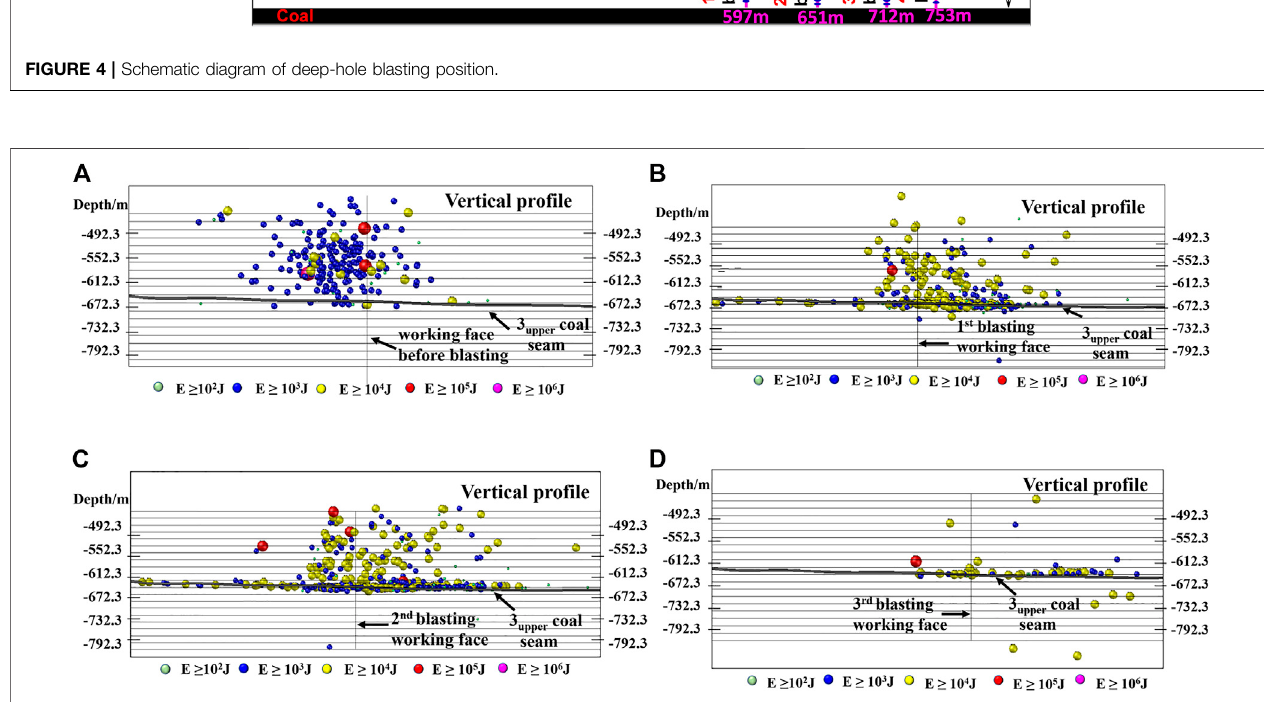
FIGURE5| Pro fi ledistributionofmining-inducedseismicitiesbeforeandafterdeep-holeblasting: (A) distributionofmining-inducedseismicitiesbeforeblasting, (B) distribution of mining-induced seismicities after the fi rst blasting at 597 m, (C) distribution of mining-induced seismicities after the second blasting at 651 m, and (D) distribution of mining-induced seismicities after the third blasting at 712 m.